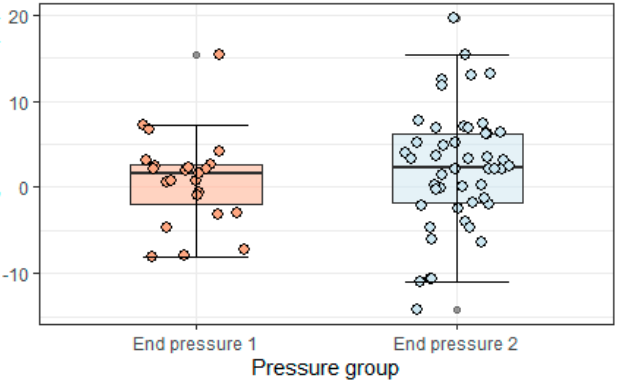
Figure 14. Percentage changes (PCs) in average flatwise MoE value of sections under different pressure values.